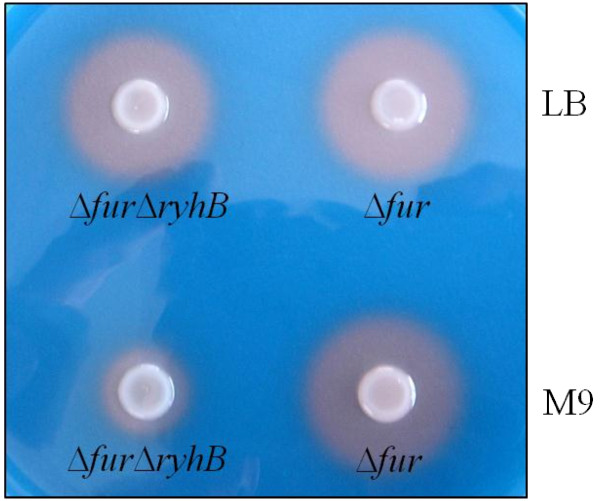
Deletion ofryhBdecreasesK. pneumoniaeΔfursiderophore production assessed using CAS assay. Each of the strains, Δfur and ΔfurΔryhB, was grown overnight in LB medium or M9 minimal medium, and then 5 μl each of cultures respectively was added onto a CAS agar plate. The orange halos formed around the colonies correspond to the iron-chelating activity of the siderophores in bacteria.